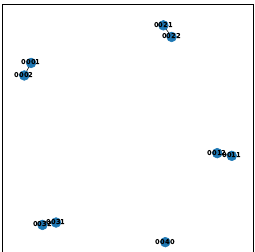
Figure 8. Fault nodes obtained after BFS.